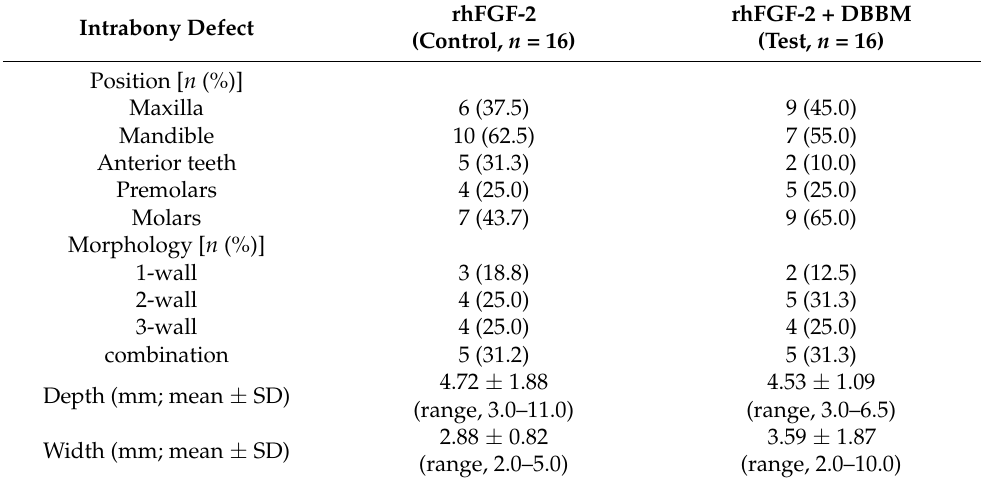
Figure 1. Representative clinical cases; ( a – f ) 60-year-old woman: intrabony defect in #24 was treated by rhFGF-2 + DBBM (test treatment); ( a ) preoperative view, the mesial site had PPD of 7 mm; ( b ) radiograph before surgery, defect width; 5 mm, depth; 3 mm; ( c ) 2-year follow-up; ( d ) radiograph at 2 years; ( e ) 4-year follow-up; PPD 2 mm; ( f ) radiograph at 4 years; ( g – l ) 53-year-old woman: #33 was treated by rhFGF-2 (control treatment); ( g ) preoperative view, PPD at the distal site was 7 mm; ( h ) radiograph before surgery, defect width; 3 mm, depth; 5 mm; ( i ) 2-year follow-up; ( j ) radiograph at 2 years; ( k ) 4-year follow-up; PPD 2 mm; ( l ) radiograph at 4 years. Table 1. Defect locations and configurations.